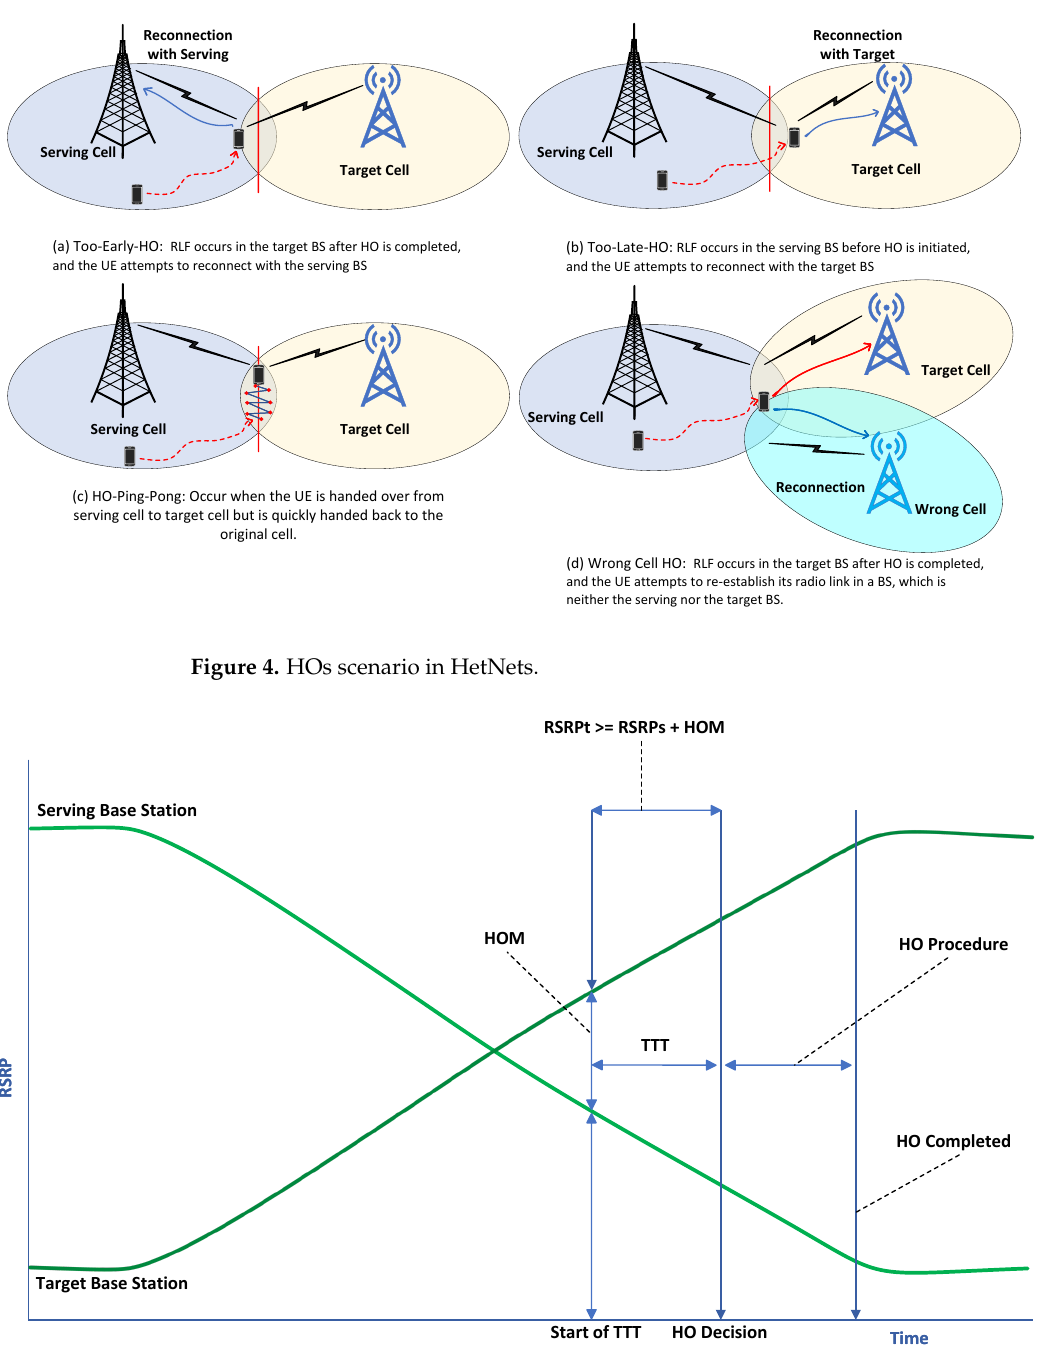
Figure 5. Handover decision and description of Handover Control